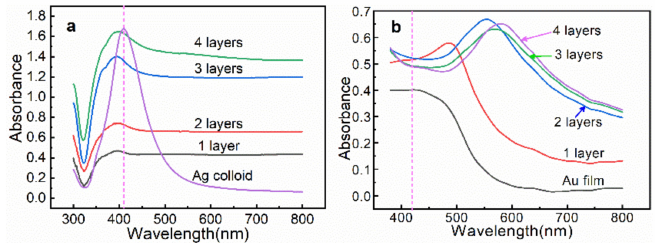
Figure 3. ( a ) UV–vis extinction spectra of the Ag colloids and the n -AgNP@glass substrates. ( b ) UV– vis extinction spectra of the Au film and the n -AgNP@Au film